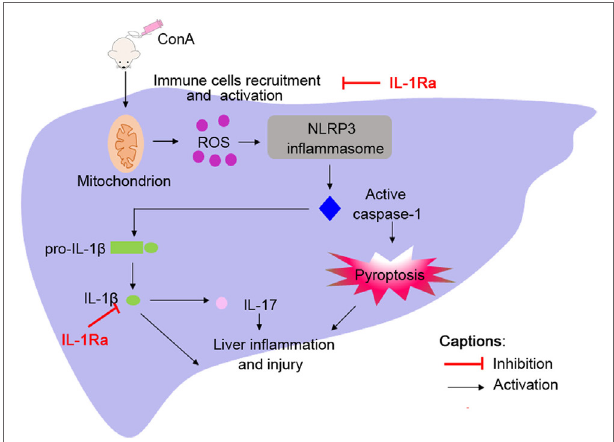
FigUre 8 | Administration of ConA-induced inflammatory cells infiltration into liver tissues followed by reactive oxygen species (ROS) generation. ROS contributed to NOD-like receptor protein 3 inflammasome activation and caspase-1 cleavage, which elicited IL-1 β production and pyroptosis, thus accelerating liver inflammation and